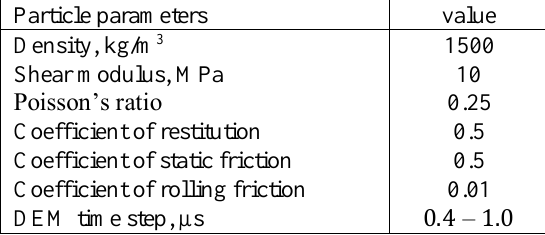
Table 3 : Particle properties used in all